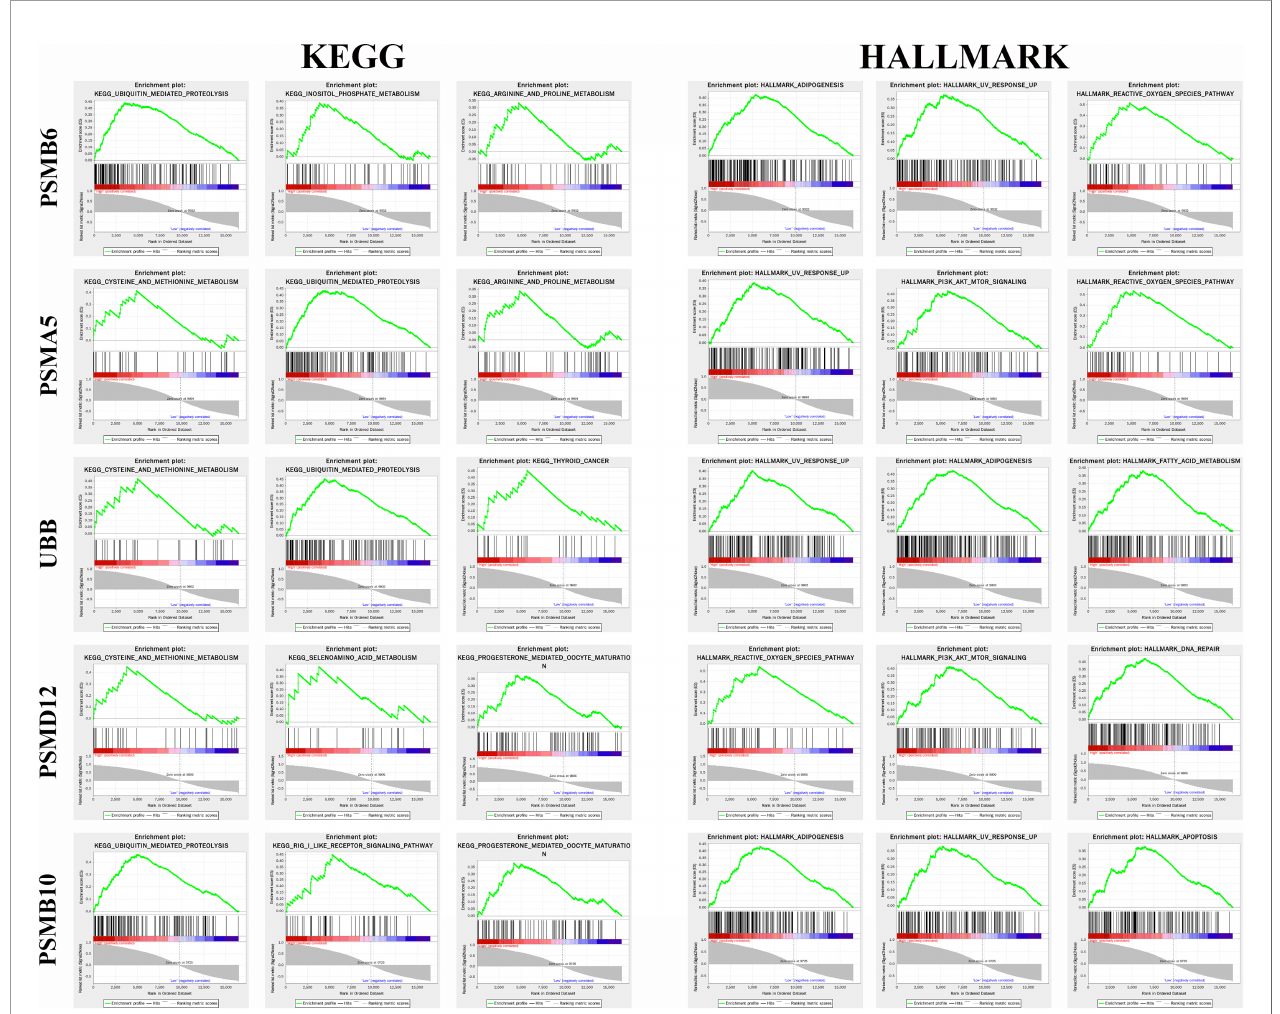
FIGURE 8 | Gene set enrichment analysis of the genes in